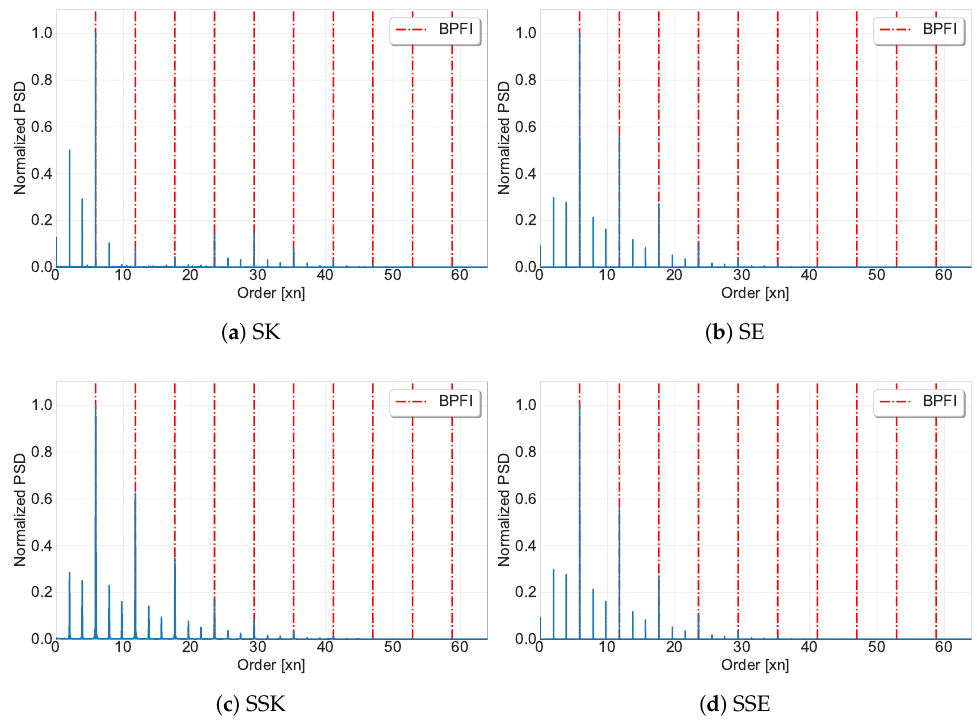
Figure 3. Examples of envelope spectra (obtained from power spectral density (PSD)) performed by simulated signal. Top row, spectral-kurtosis (SK) and spectral-entropy (SE) estimators; bottom row, their sliding versions (sliding spectral kurtosis (SSK); sliding spectral entropy (SSE)). Order represents shaft-speed